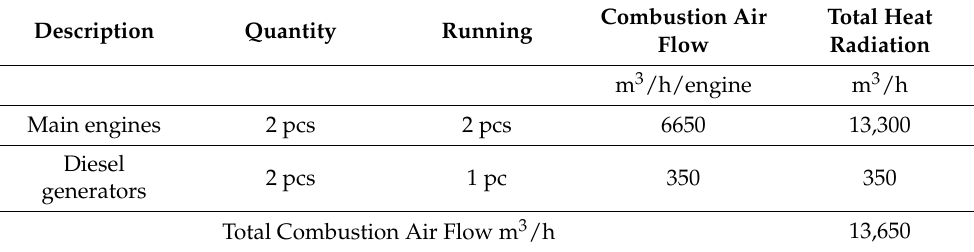
Table 2. Requested combustion air flow